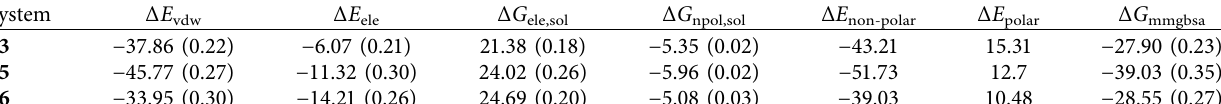
Table 3: Binding free energy components of protein-ligand complexes (in units of kcal/mol).